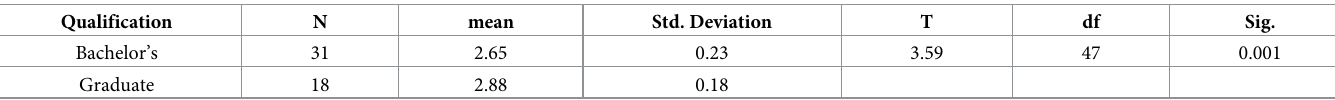
Table 10. The (t) test results to detect statistical differences between the means of physics teachers’ responses pertaining to the qualification variable.